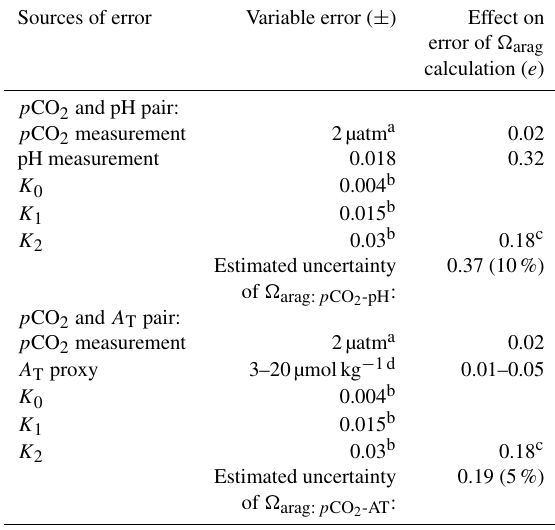
(cid:16) P (cid:17) 1 / 2 e 2